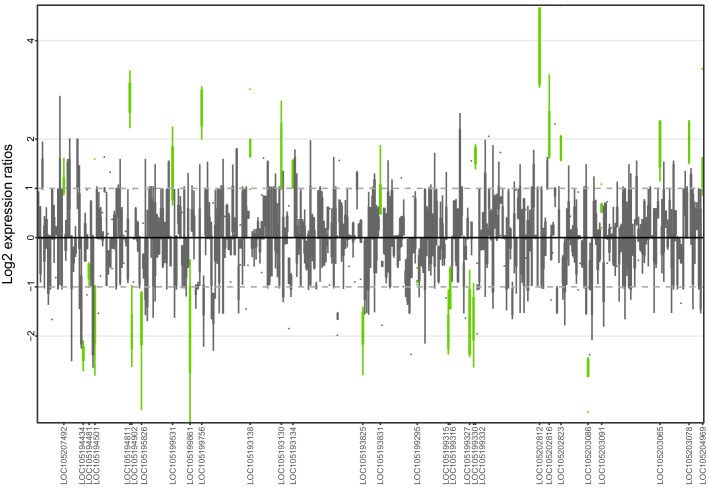
Allele-specific expression for genes in the fire ant social supergene for whole bodies of North American queens.Differences in allele-specific expression between variants (y axis) for all genes in the supergene with enough expression information (x axis). Significant expression differences (BH adjusted p<0.05 from Wald test in DESeq2) are in green and the RefSeq ID of the significant gene is outlined in the x axis. Non-significant differences are in gray. Within each plot, each box shows the distribution of log2 expression ratios between SB and Sb. Positive values indicate higher expression in SB; negative values indicate higher expression in Sb. The dashed line shows log2 expression ratios = 1, that is a two-fold gene expression difference in either direction. Genes are in chromosomal order, showing that genes with allelic biases in either direction are distributed throughout the supergene, rather than localized in a manner that would be expected by strata of differentiation. Thicker boxes have higher median read counts than thinner boxes.Figure 1—figure supplement 3—source data 1.Allele-specific expression for genes in the fire ant social supergene for whole bodies of North American queens.The columns in the dataset stand for: refseq_id, gene ID in the RefSeq database; body_part, body part from which the RNA was extracted; median_expression, median DESeq2 normalized expression per gene across all samples per body part; littleb_expression, DESeq2 normalised read counts for the Sb allele, bigB_expression, DESeq2 normalised read counts for the SB allele; sample_id, ID for the replicate; population, population of origin of the replicate, total_expression, combined SB Sb expression per gene per replicate; lfc_SB-Sb, log2 fold changes between SB and Sb DESeq2 normalized read counts; significant, whether a gene show significant differences in expression levels between Sb and SB according to either our linear mixed effects model or DESeq2's Wald test.